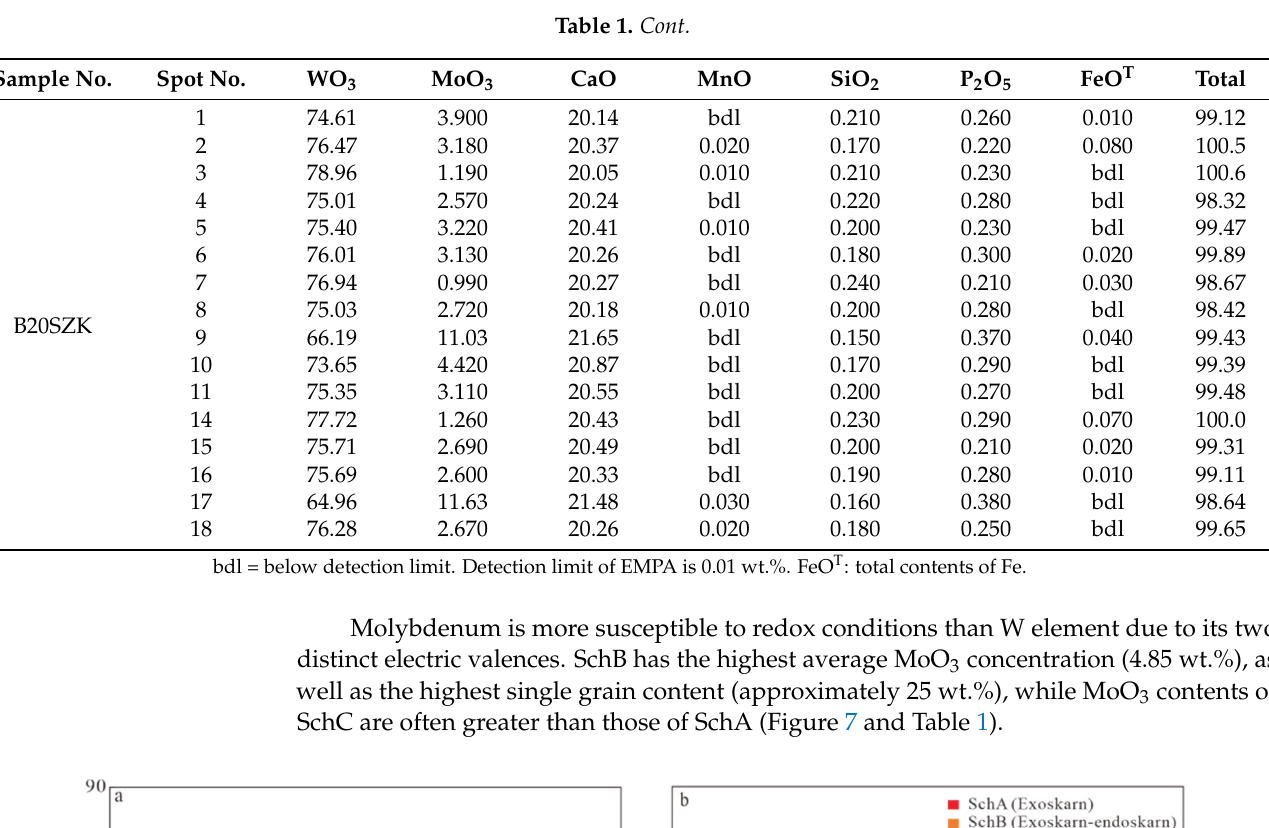
Table 2. Results of trace element analysis in scheelite from Tongshankou deposit (ppm). Sample No.